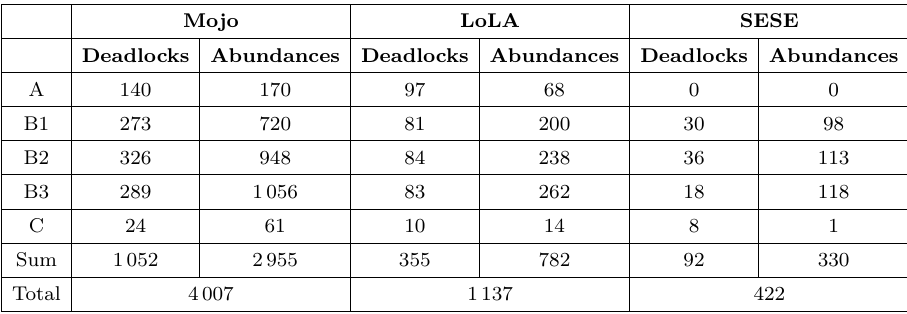
Table 1. Number (of causes) of deadlocks and